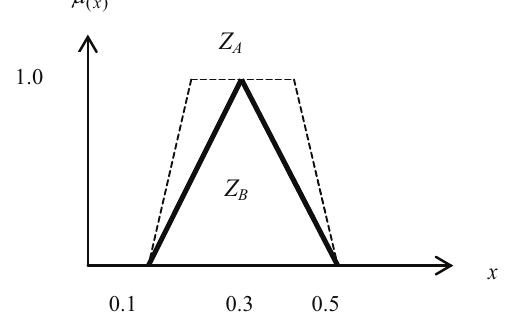
Fig 4.Z – fuzzy numbers Z A and Z B of Case